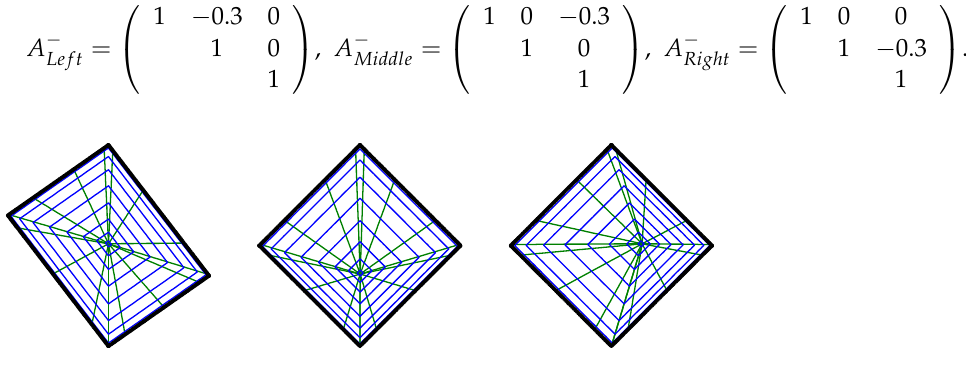
. , A + , A + Right Left Middle